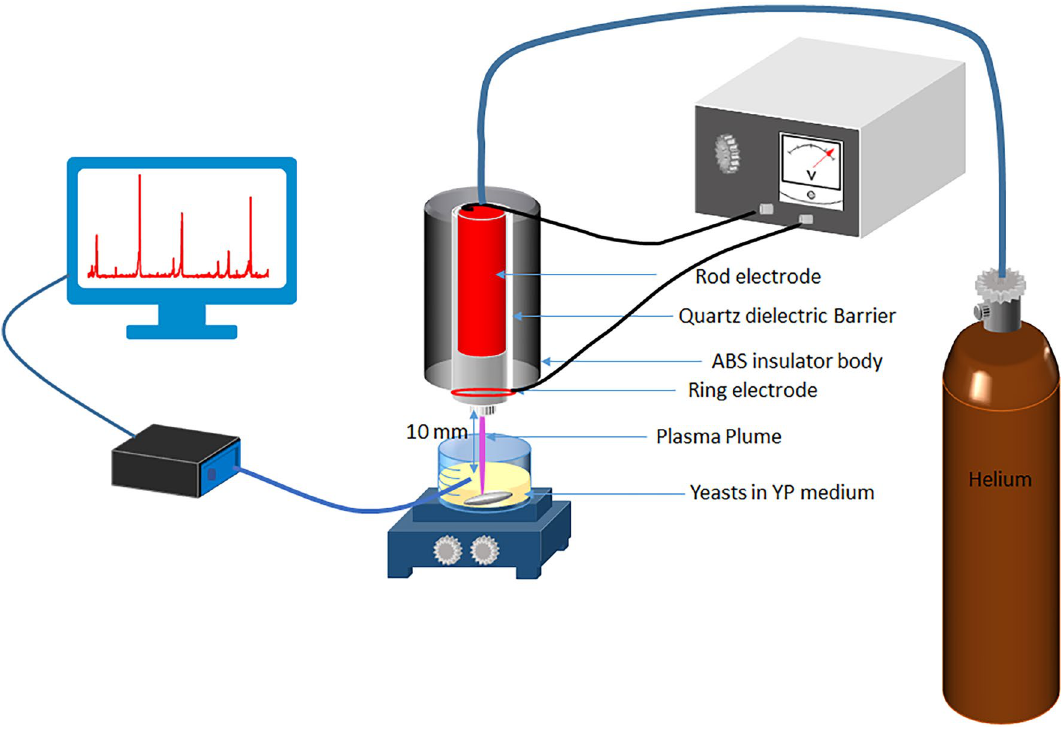
Figure 8. Plasma schematic and treatment